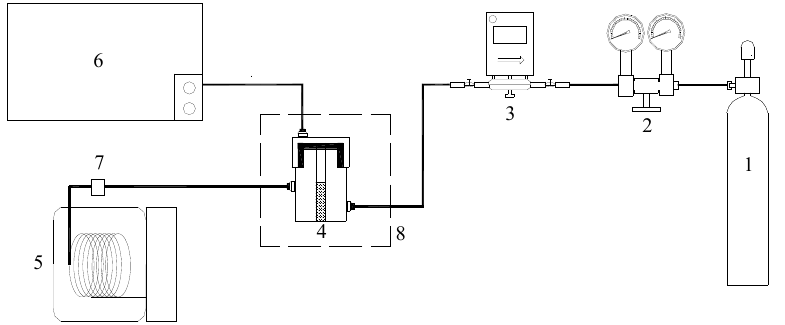
Figure 9. Experimental device of model compound oxidation. 1-Dry Air 2-Pressure Reducing Valve 3-Flow Controller 4-Sample pot 5-Gas Chromatography and Mass spectrometry 6-FUL9790 Gas Chromatography Apparatus & Infrared Gas Analyser 7-Integrated Temperature Sensor 8-Temperature Programmed